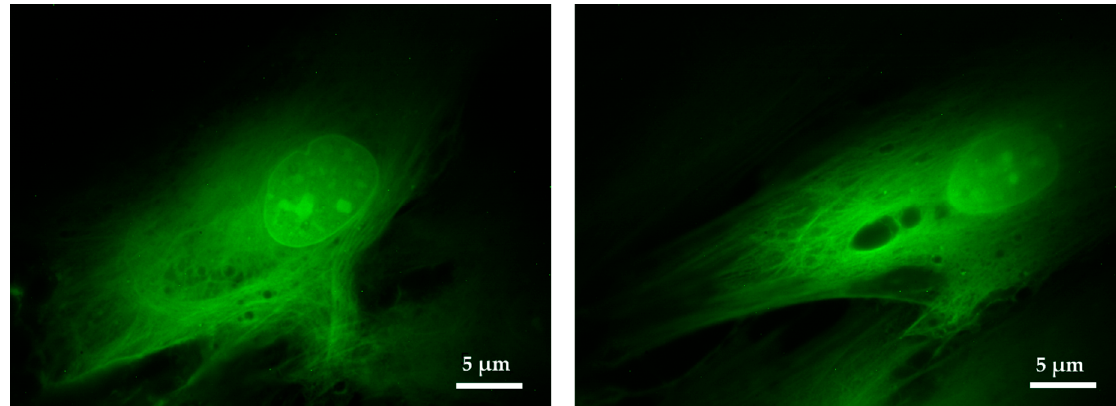
Figure 6. Close up visualization of fibroblast cells. Details of the fibers composing the cellular cytoskeleton and other intracellular structures can be appreciated. Images obtained with the Olympus UPLFLN 100x and processed using ImageJ.